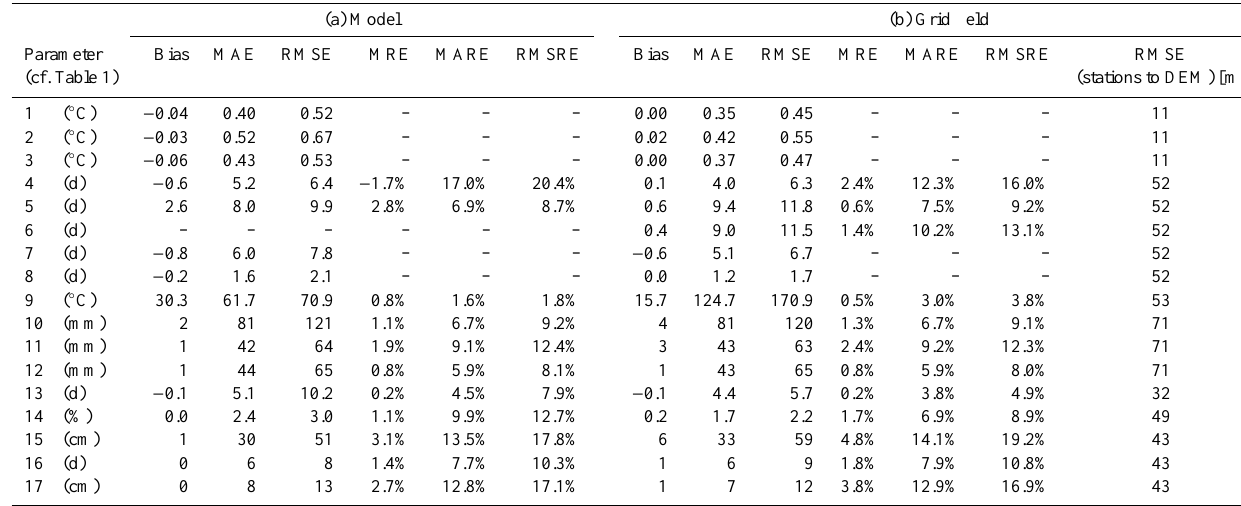
Table 3. Error measures (bias – mean error, MAE – mean absolute error, RMSE – root mean squared error, MRE – mean relative error, MARE – mean absolute relative error, RMSRE – root mean squared relative error) describing the deviations between observed values and simulated values as generated by the respective interpolation models (a) and as indicated on the final grid fields (b).